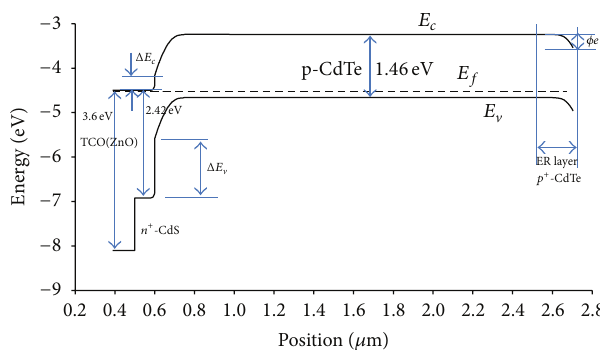
Figure 4: Band diagram of TCO/CdS/CdTe cell with added electron-reflector-extended region (ER layer).